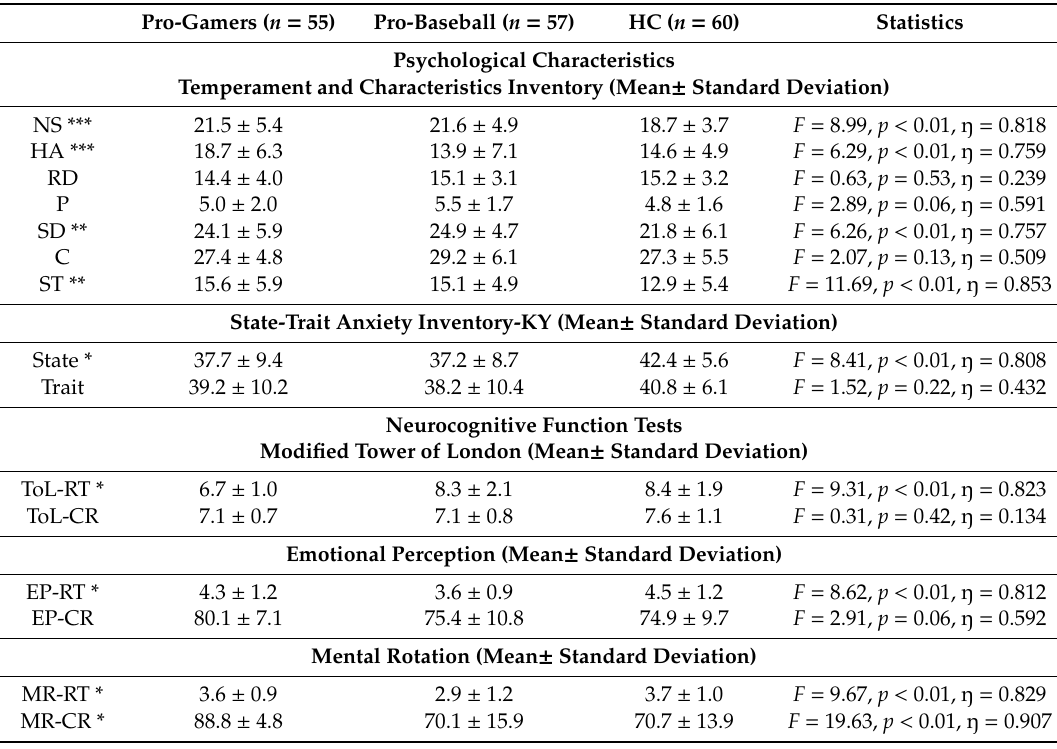
Table 2. Psychological and cognitive characteristics of all